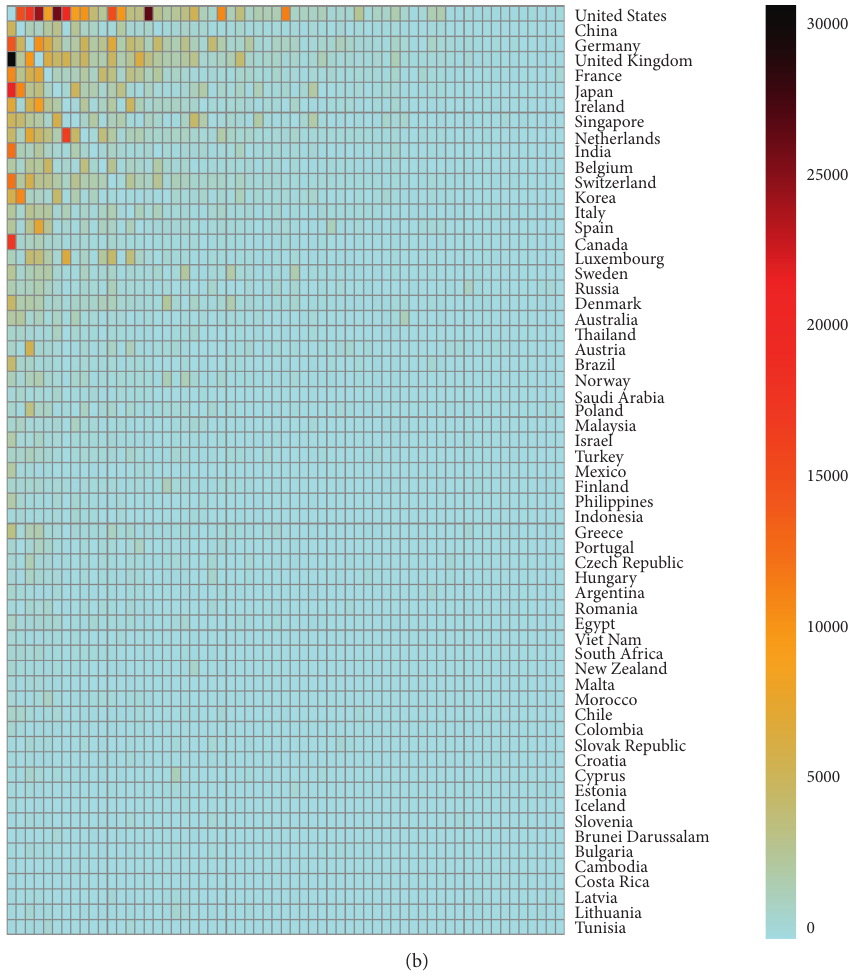
Figure 4: Export heat map of producer services trade. (a) 2000; (b)